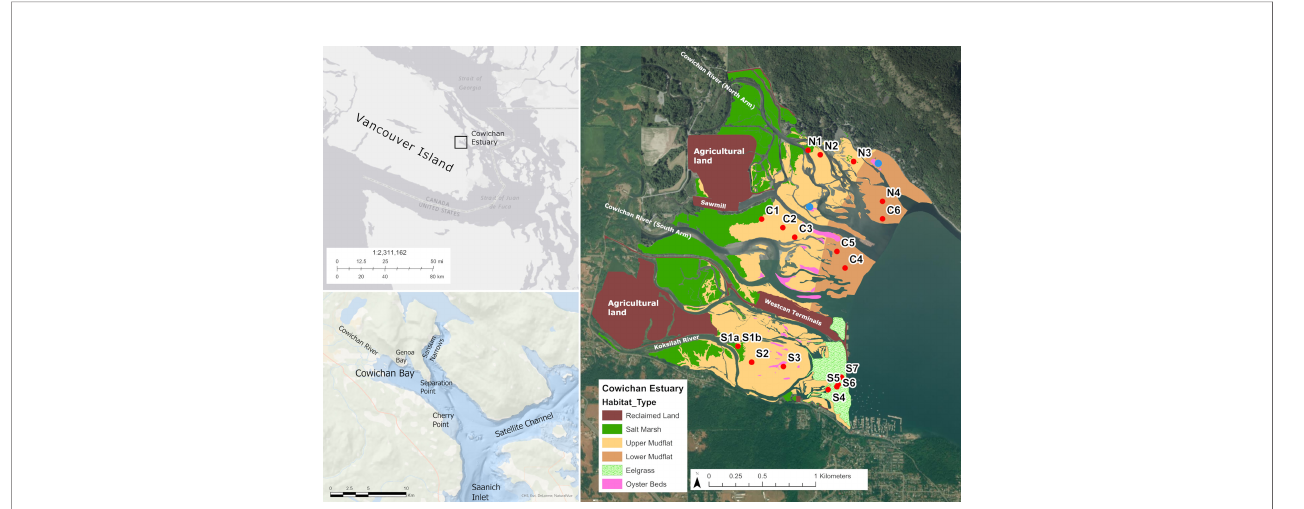
FIGURE 1 | Location map and sediment core sampling sites in the Cowichan Estuary on Vancouver Island, British Columbia, Canada. The rightmost map shows the four dominant habitats found at the Cowichan Estuary: the salt marsh at the landward edge (N1, C1, S1a, S1b), and the seagrass meadow at the seaward edge. The mud fl at is in between the salt marsh and seagrass meadow, separated in the upper mud fl at (N2, N3, C2, C3, C2, S3), the lower mud fl at (N4, C4, C5, C6, S4). Pink shading outlines mapped oyster beds, with blue circles indicating oyster sediment sampling sites. Geo-referenced habitat polygons were delineated and classi fi ed by visual aerial photo interpretation of an unoccupied aerial vehicle (UAV)-acquired orthomosaic and veri fi ed using ground-based GIS